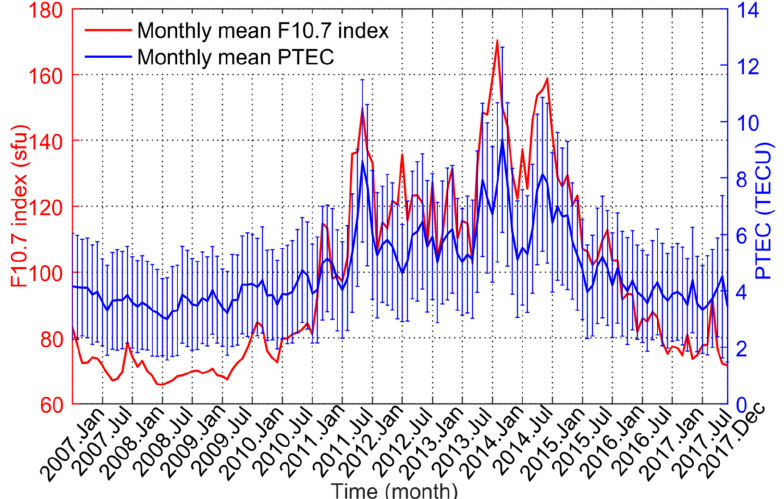
Figure 11. Monthly mean F10.7 index and monthly mean PTEC from January 2007 to December 2017. To determine the correlation between PTEC and solar activity in the daytime and nighttime, we divided the plasmaspheric TEC into the daytime region and nighttime region, and the division standard was the same as in the previous section. Similarly, the values of PTEC in the daytime and nighttime were averaged by month, respectively. The mean values and the standard deviations are shown in Figure 12. The variations of PTEC in the daytime and nighttime are basically synchronous with differences less than 2 TECU, and both show consistency with the variation of the monthly mean F10.7 indices.